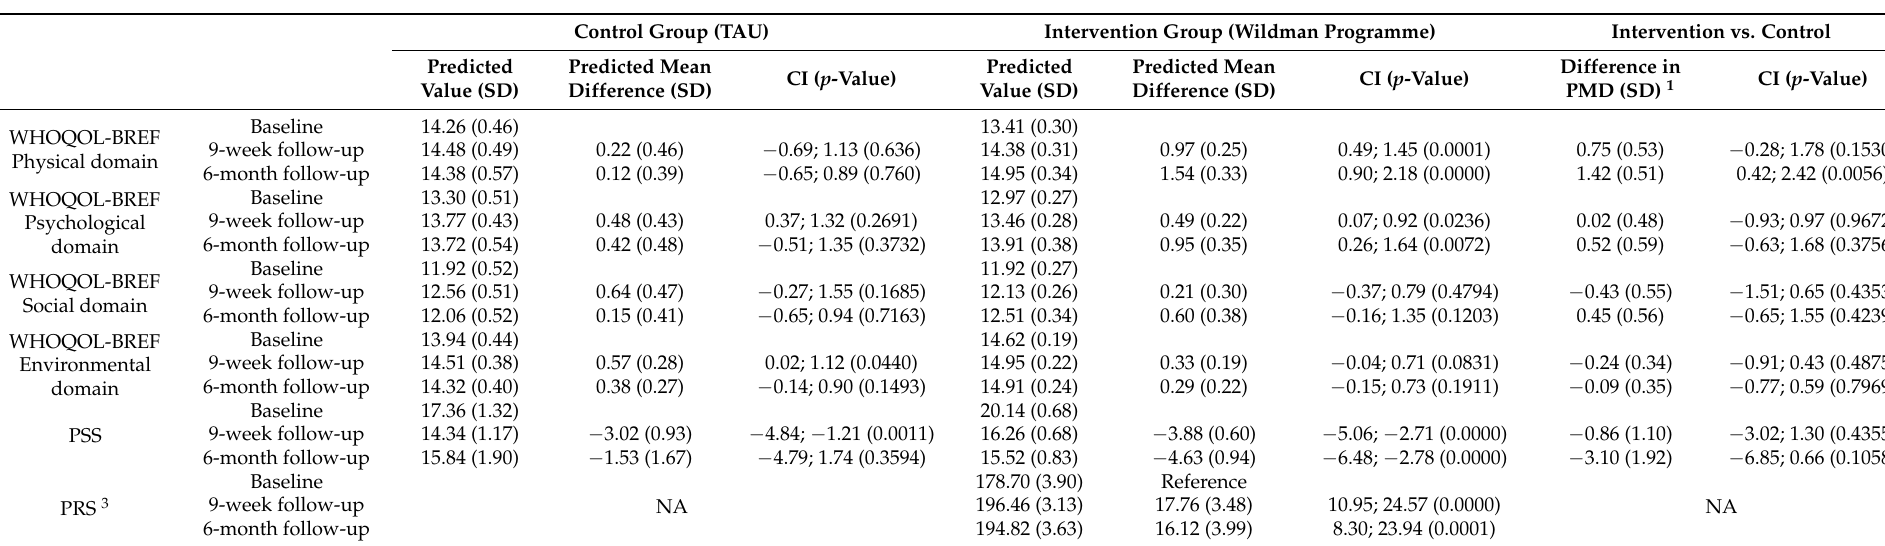
Table 3. Predicted values and predicted mean differences of primary and secondary outcomes over time and by group, from adjusted linear mixed models.